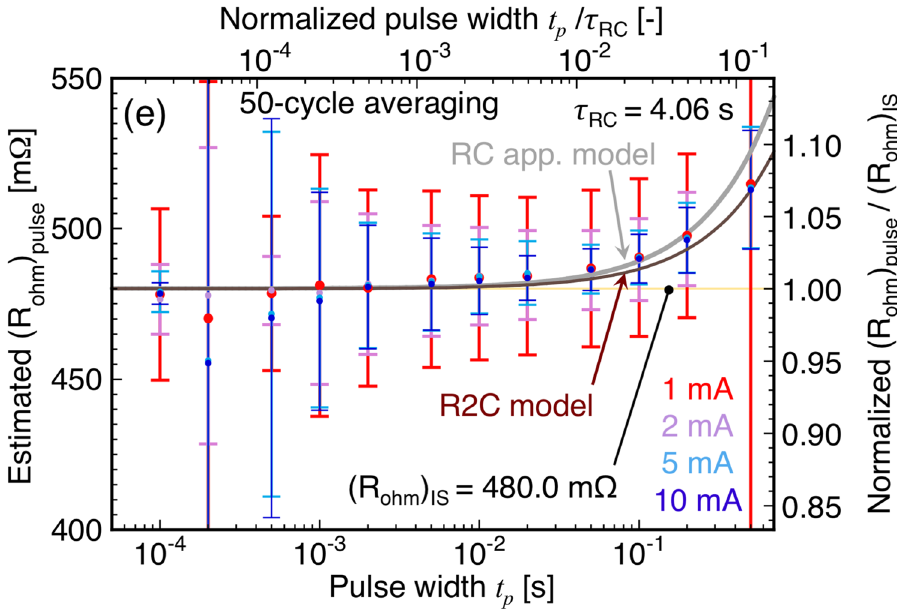
Figure 6. Pulse width ( t p ) dependence of estimated ohmic resistance ( R ohm ) pulse using 50-cycle averaging at each current. The upper axis shows normalized pulse width t p / τ RC . The results using the R2C and RC approximation models with ( R ohm ) IS are also